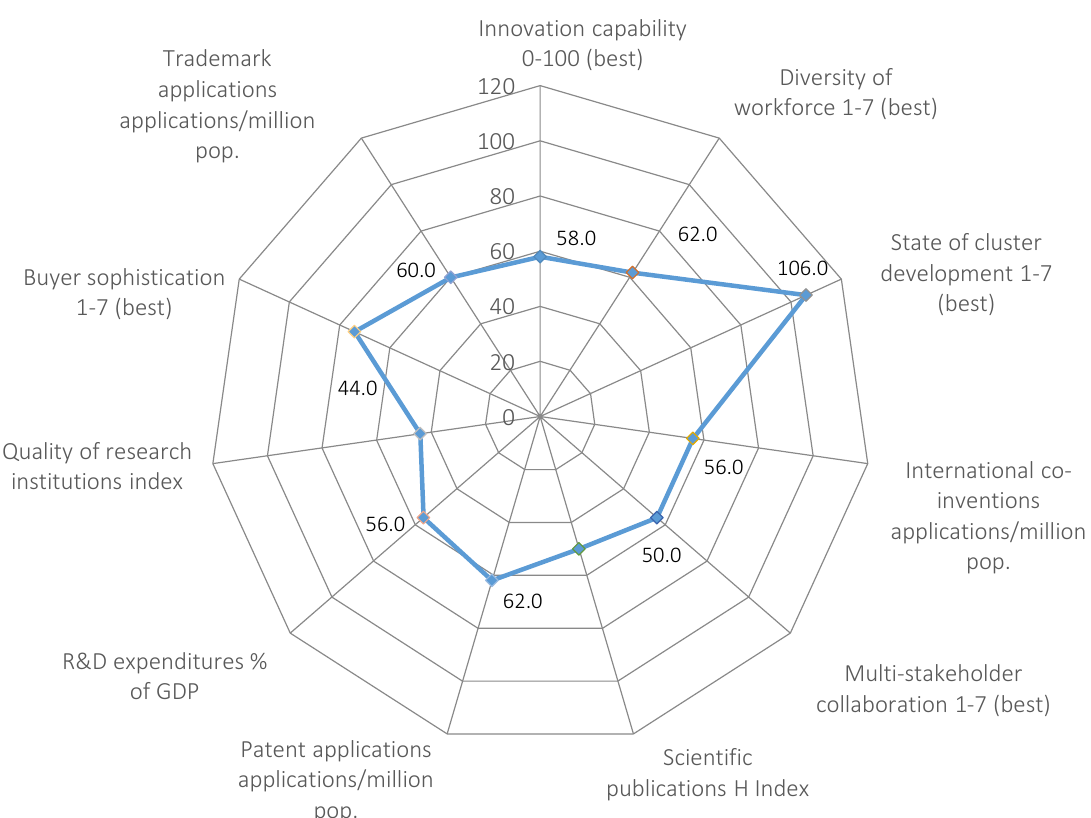
Figure 3. “Innovation capability” element estimation of Global Competitiveness Index of Ukraine in 2018,